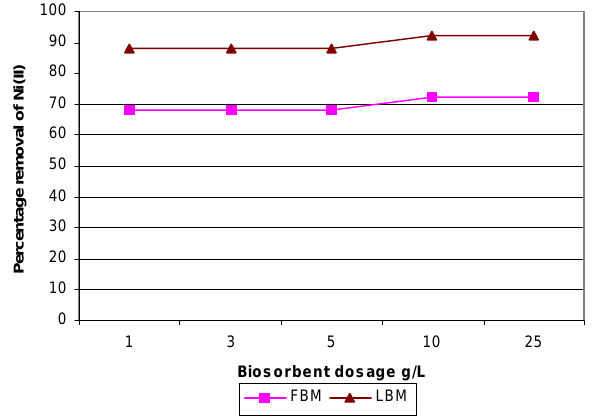
Figure 2: Effect of Biosorbent Dosage on the biosorption of